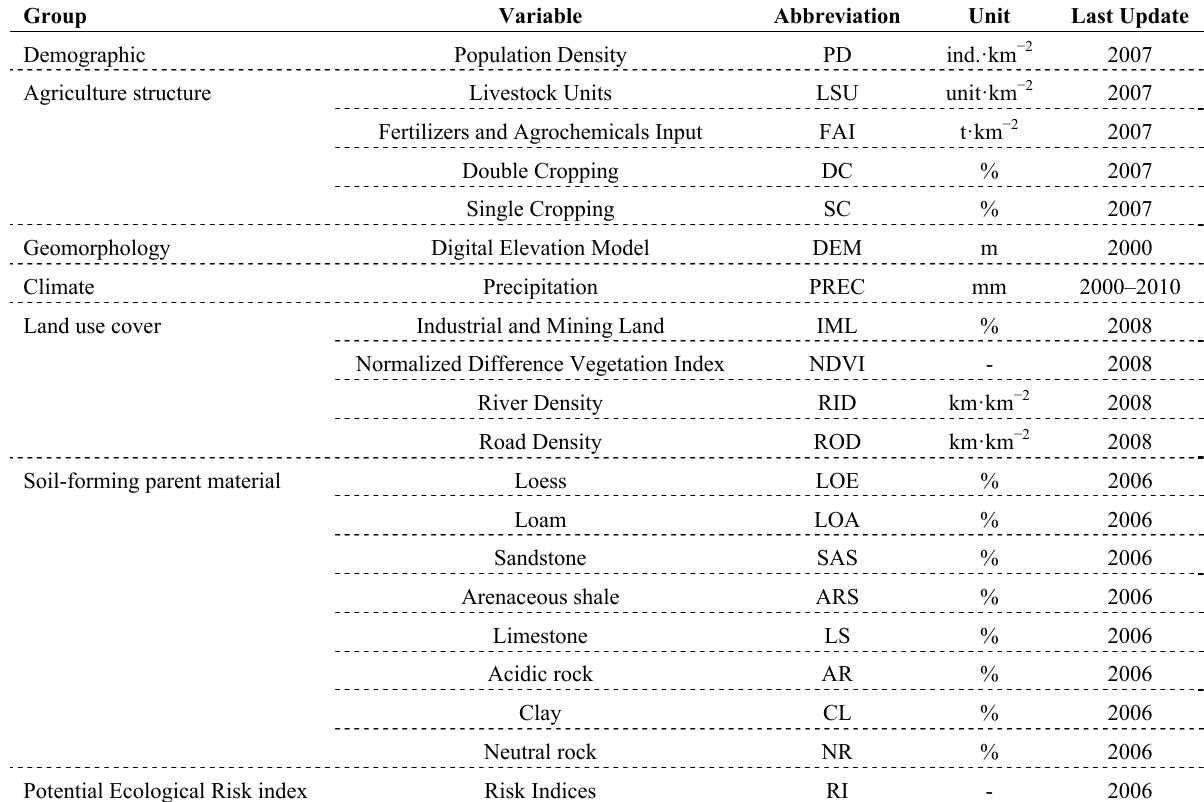
Table 2. Metadata used to classify the social-ecological patterns of heavy metals.